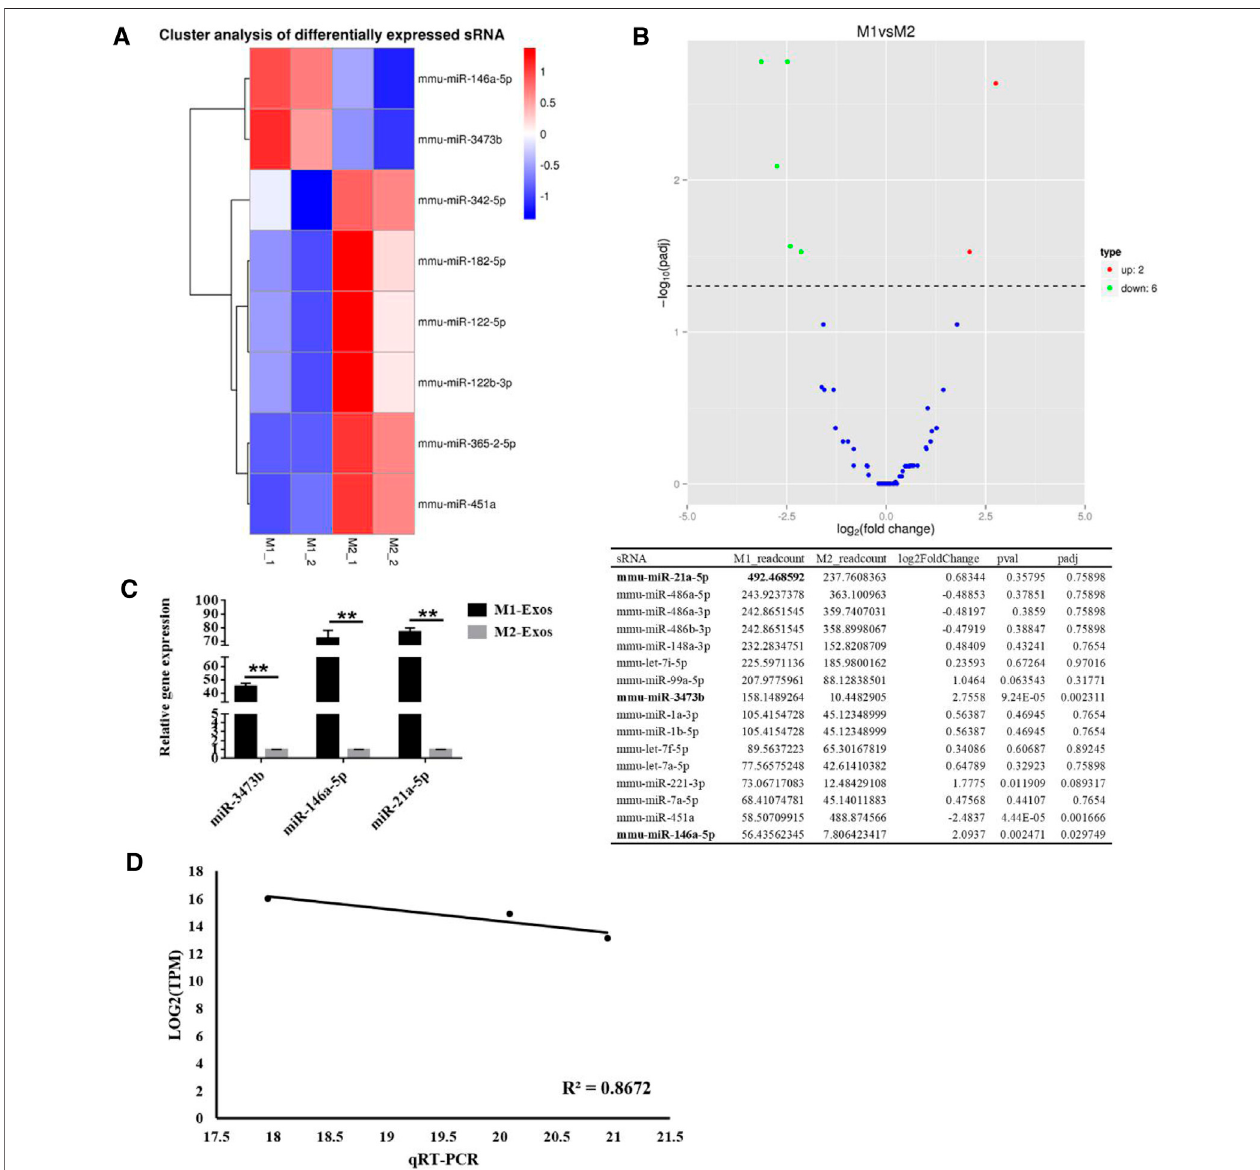
FIGURE 3 | Identifcation of diferentially expressed miRNAs between M1-Exos and M2-Exos. (A) Heat map identifed the diferently expressed miRNAs of M1-Exos and M2-Exos. Red and blue were used to indicate the up-regulated and down-regulated genes respectively. n (cid:2) 2 for each group. M1, Exosomes were extracted from medium of M1 macrophage medium; M2, Exosomes were extracted from medium of M1 macrophage medium; (B) Volcano plot comparing the levels of gene expression between M1-Exos and M2-Exos. Red and green dots represent upregulated and downregulated miRNAs ( > 2.0 fold change and p < 0.05). (C) The expression of miR-3473b, miR-146a-5p and miR-21a-5p was detected by qRT-PCR. Data are presented as mean ± SD. **p < 0.01 represent signi fi cant differences betweentheindicatedcolumns. (D) GeneexpressioncorrelationbetweenqRT-PCRandRNA-seqdata.TePearsoncorrelationcoef fi cientsandlinearregressionlineare